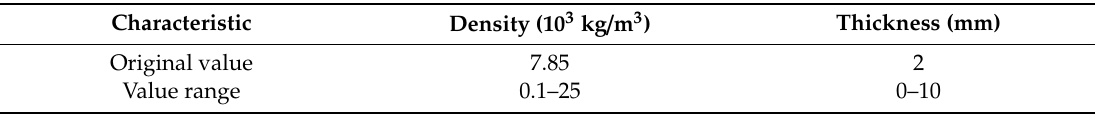
Table 5. Parameters of the different inertial supports.